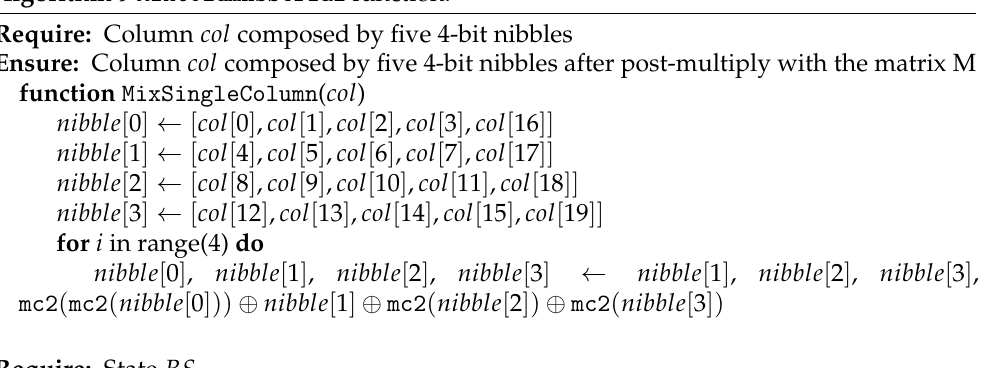
Algorithm 9 MixColumnsSerial